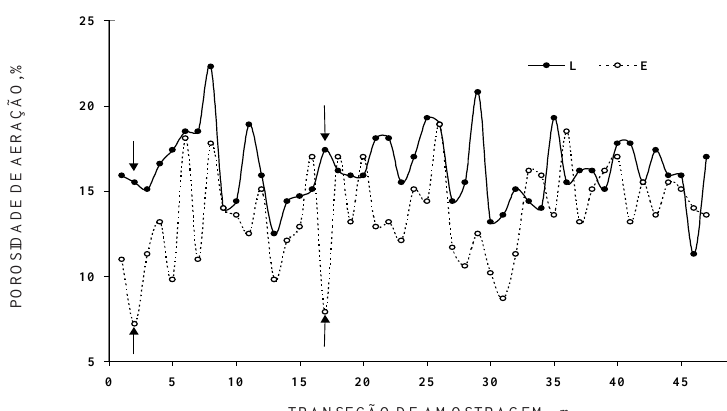
Figura 5. Porosidade de aeração na linha (L) e entrelinha (E) no sistema de preparo convencional ao longo de uma transeção perpendicular às linhas de cultivo em um Latossolo Roxo cultivado com milho, para umidade do solo equivalente à tensão de 0,033 MPa.